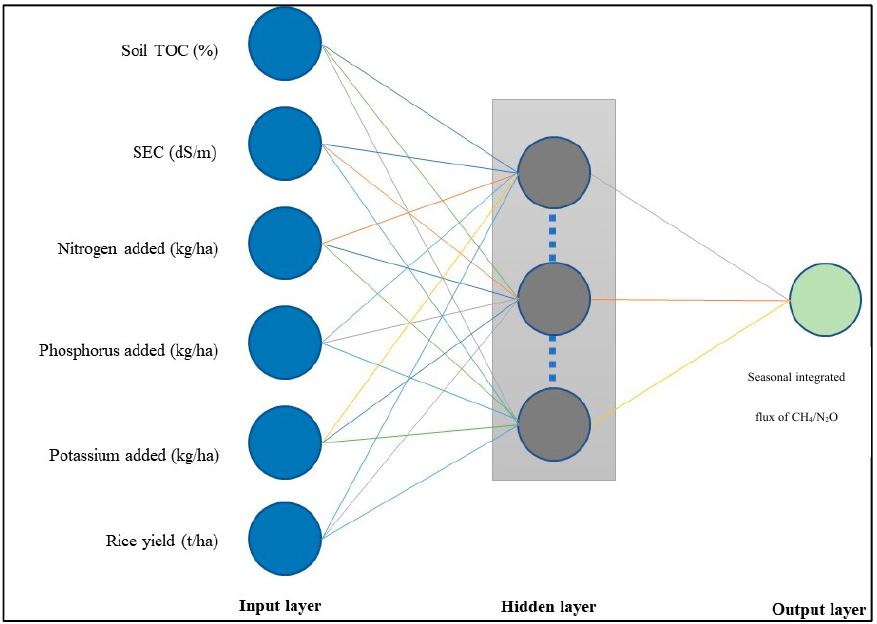
Figure 1. Schematic of the ANN model architecture.